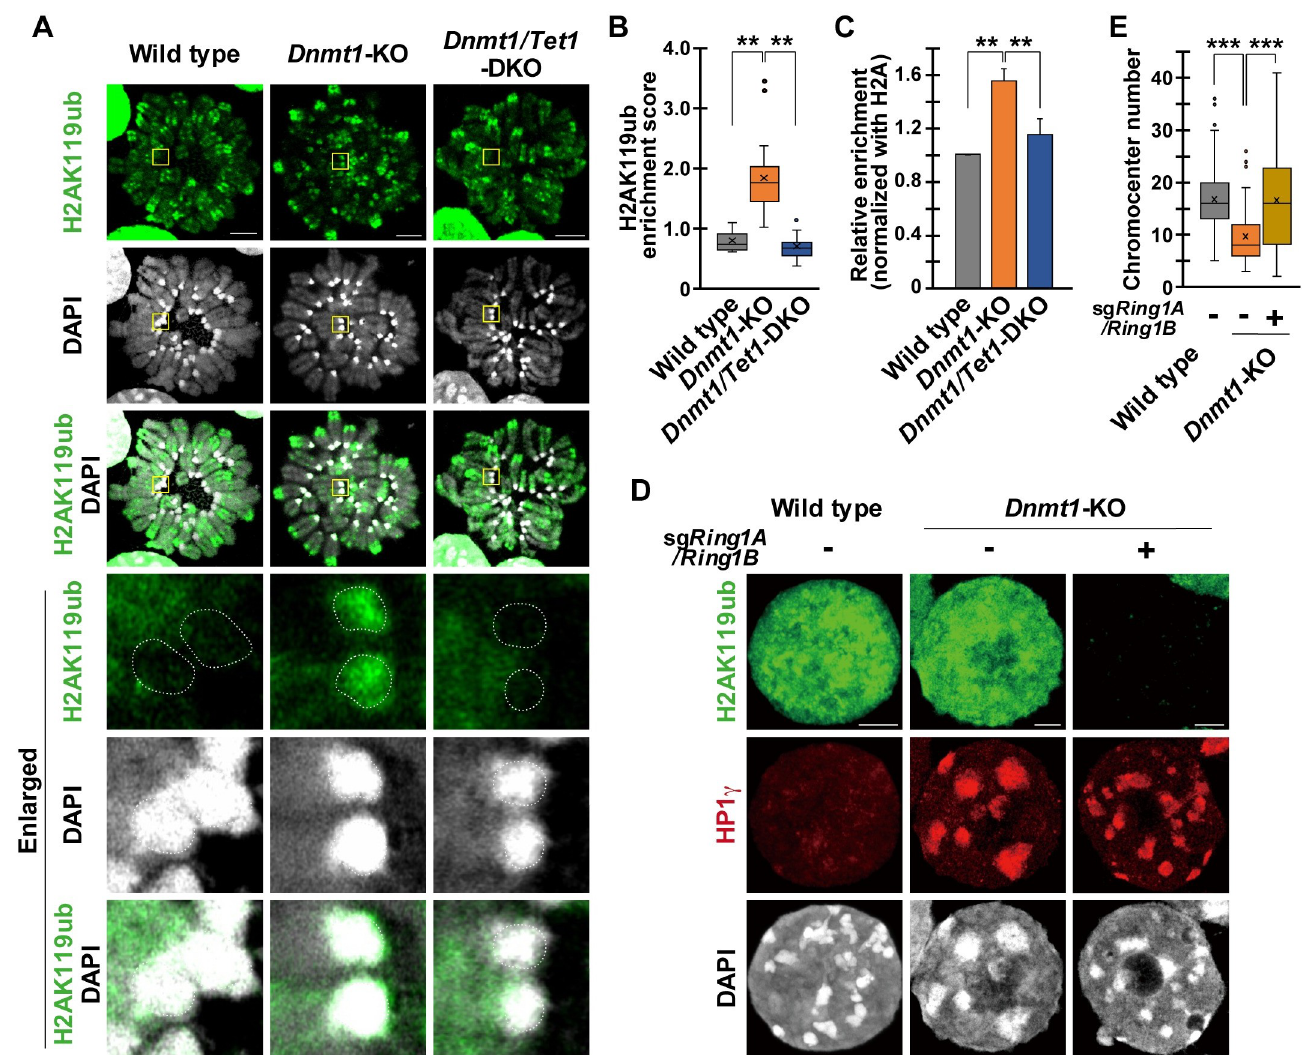
Fig 3. The critical role of PRC1 in the chromosome clustering in the DNA hypomethylated ESCs. (A) : Representative immunostaining images of the surface- spread nuclei of the wild-type, Dnmt1 -KO and Dnmt1/Tet1 -DKO ESCs. The yellow squares indicate the enlarged areas shown on the bottom. The white dashed circles indicate the PCH. (B) : Quantification of immunostaining of H2AK119ub, related to (A). The enrichment score is calculated by the relative signal intensity of PCH to the entire chromosome. An average of 3 chromosomes was calculated for each cell. n = 20 per cell line. (C) : ChIP-qPCR for H2AK119ub at the major satellite repeats in the wild-type, Dnmt1 -KO and Dnmt1/Tet1 -DKO ESCs. Each bar represents relative enrichment to wild-type after normalization against H2A ChIP. n = 3 per cell line. (D) : Representative immunostaining images of surface-spread nuclei of the wild-type, Dnmt1 -KO and Dnmt1/Ring1A/1B -TKO ESCs. Cells were analyzed 4 d after the transfection of the CRISPR cassette. (E) : Boxplot showing the number of distinct chromocenters in the nuclei of ESCs, related to (D). Wild-type, n = 97; Dnmt1 -KO, n = 75; Dnmt1/Ring1A/1B -TKO, n = 64. P values were calculated using the Mann-Whitney U-test. ��� P < 0.001; �� P < 0.01. Scale bar, 5 μ